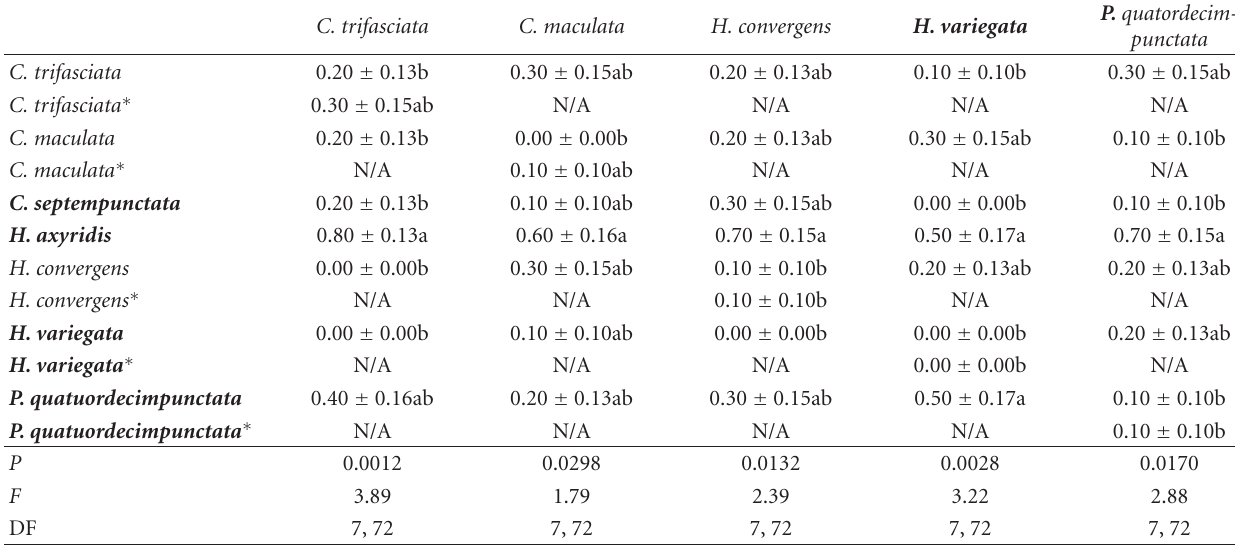
Table 4: Number of aggression events (mean ± SE) received by C. trifasciata, C. maculata, H. convergens, H. variegata , and P. quatuordeci- mpunctata in di ff erent competition contexts (see text for details). Means in each column followed by the same letter are not significantly di ff erent from each other (Tukey’s HSD tests, P < 0 . 05). Nonnative species are printed in bold font.